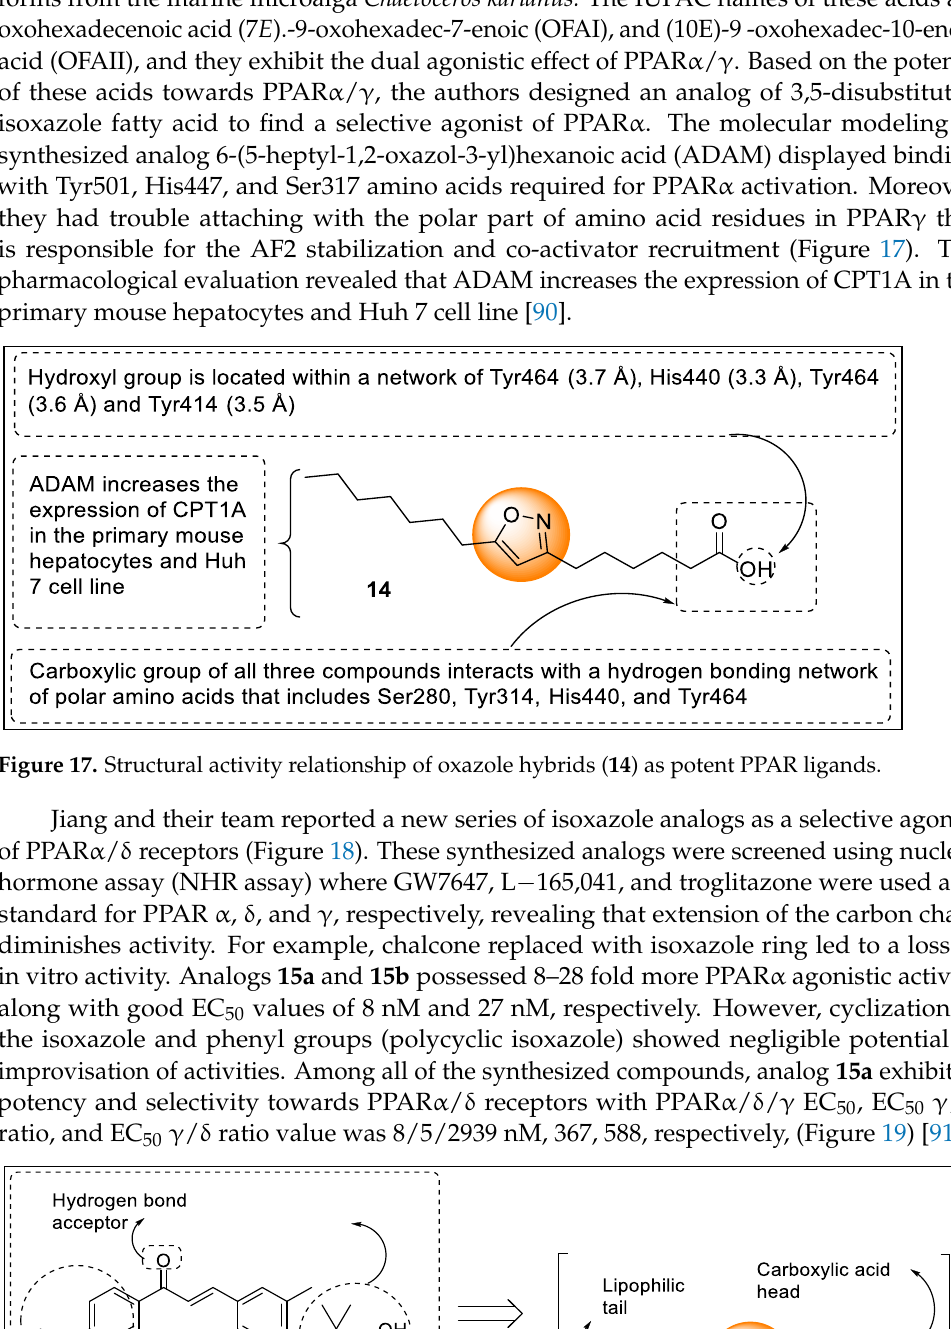
Figure 16. Structural activity relationship of oxadiazole hybrids ( 13 ) as potent PPAR ligands.